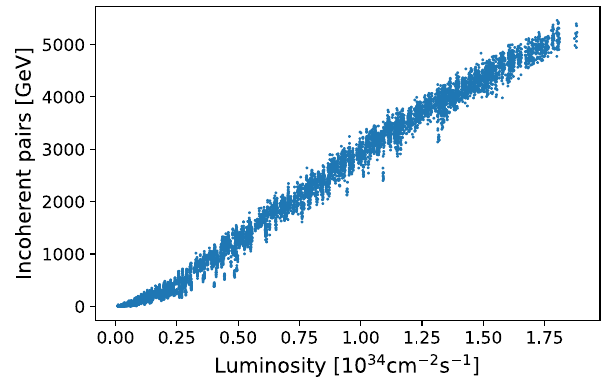
FIG. 5. Simulation of 1000 cases with randomly distributed sextupole offsets. For each case, the full beam-beam simulation was run 10 times. We plot the luminosity and total energy in incoherent pairs in the BeamCal.